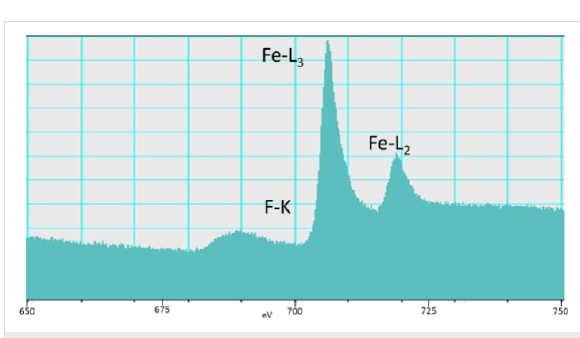
Figure 5: EEL spectra of C(FeF 2 ) 0.25 _300. The spectrum shows the F K-edge and the Fe L3- and Fe L2-edges.